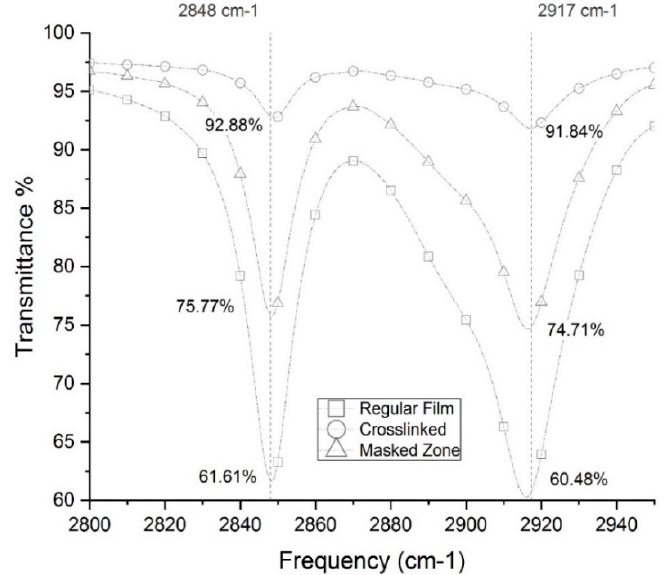
Figure 5. FTIR comparing regular LLDPE film and masked and stabilized film in a 2800 cm − 1 to 2950 cm − 1 range.